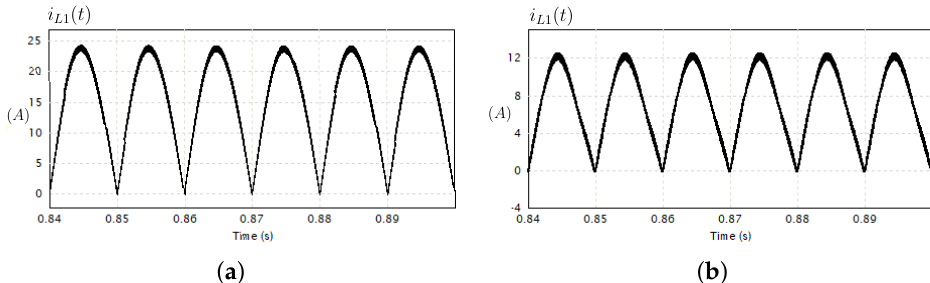
Figure 17. Waveforms of inductor current i L 1 ( t ) in: ( a ) Boost mode. ( b ) Buck